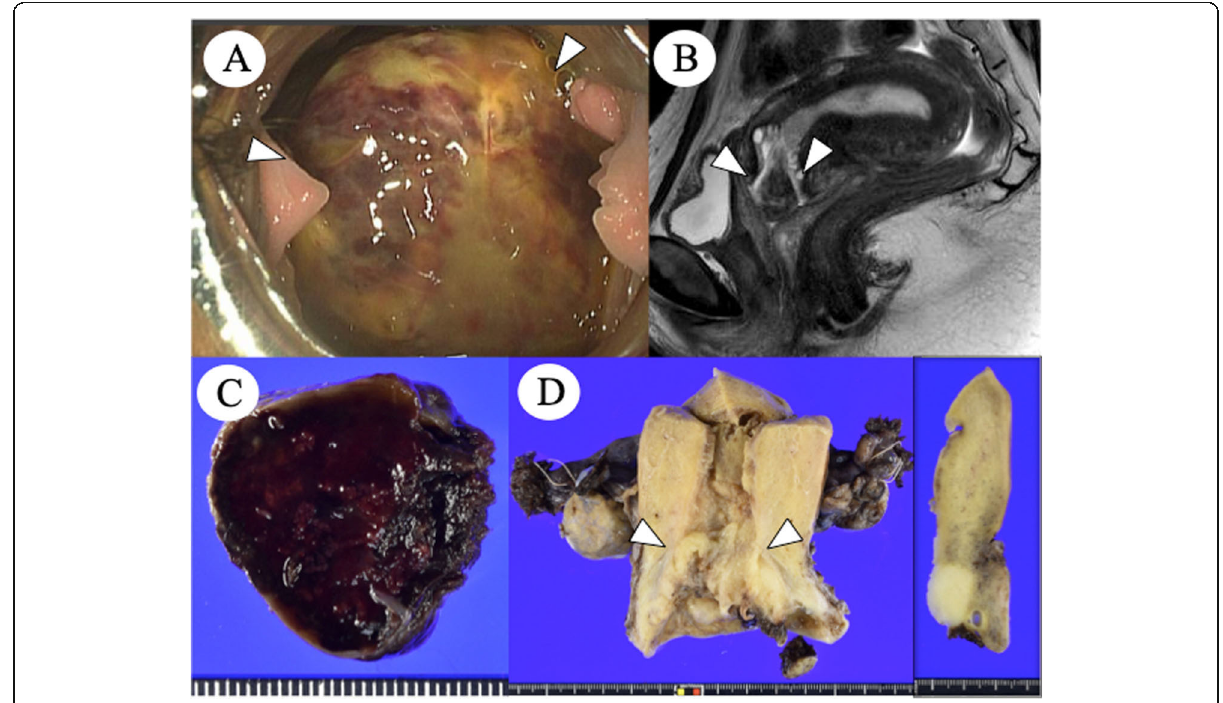
Fig. 1 a Colposcopic image of the cervical mass (arrowhead). b Sagital magnetic resonance image of the low-intensity cervical mass (arrowhead). c Cut section of the cervical mass. d Yellow-white surgical specimen (arrowhead) from the uterus. Inset: cut surface of the